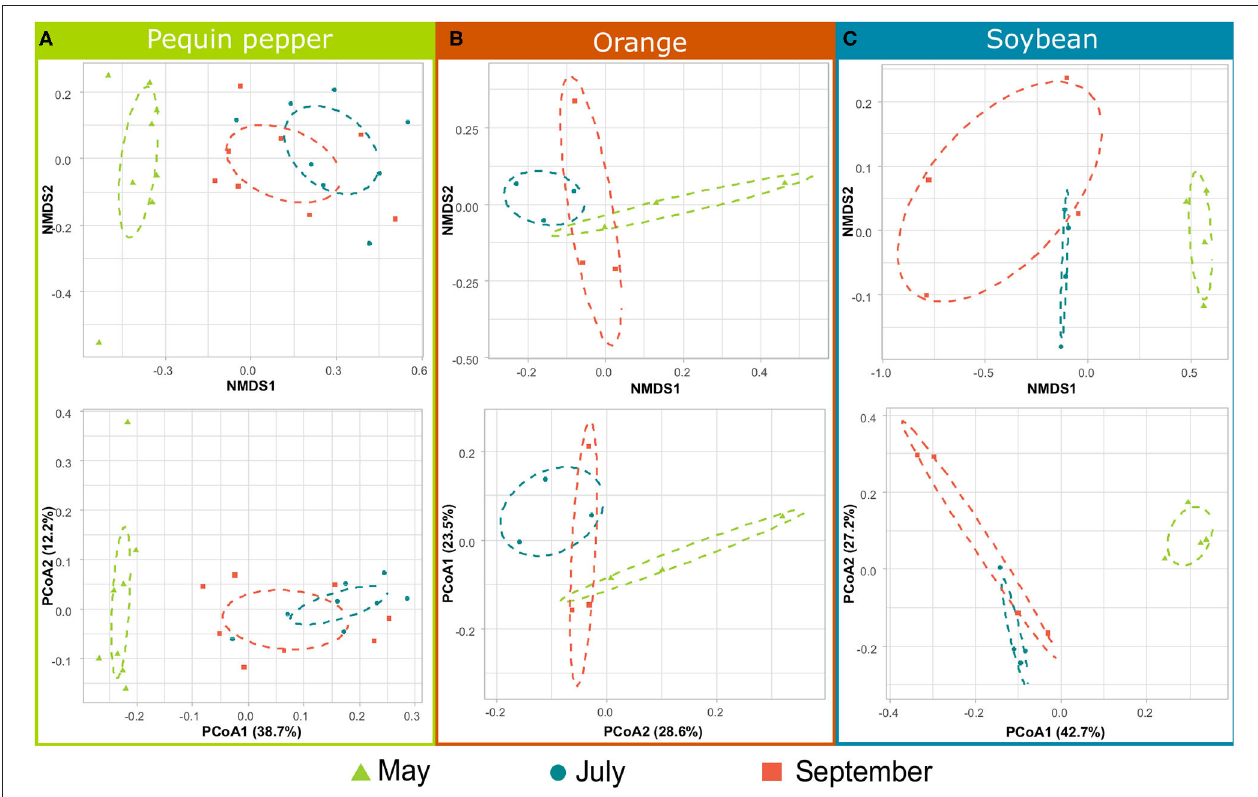
FIGURE 5 | Non-metric multidimensional scaling (NMDS) and principal coordinate analysis (PCoA) plots show differences in community composition among sampling times for (A) Pequin pepper, (B) orange tree, and (C) soybean. Distribution of distinct groups is represented by 95% confidence interval ellipses. Variation explained by the data in PCoA plots is presented in